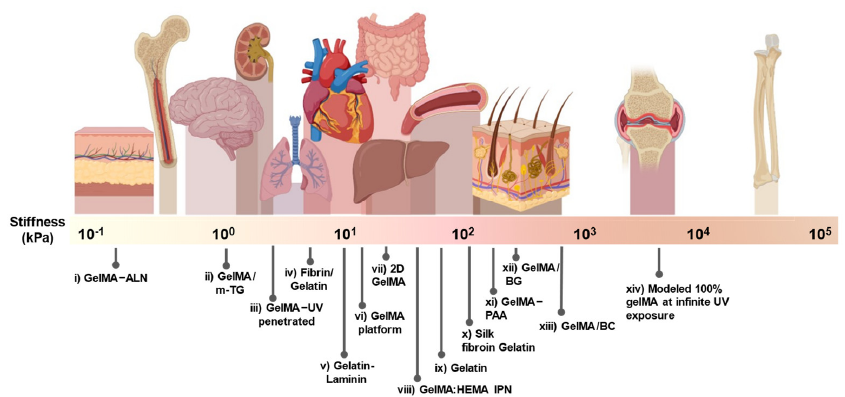
Figure 9. Depiction of gelatin tunability by comparing its stiffnesses against different tissue stiffness. ( i ) Alendronate-functionalized GelMA [154], ( ii ) GelMA/m-TG [121], ( iii ) GelMA–UV penetrated [155], ( iv ) Fibrin/gelatin [156], ( v ) Enzyme crosslinked gelatin-laminin hybrid [33], ( vi ) GelMA based platforms [33], ( vii ) 2D Photo-crosslinked GelMA [157], ( viii ) GelMA and poly(2-hydrox-ethyl methacrylate) (pHEMA) interpenetrating network (IPN) hydrogels [158], ( ix ) Gelatin of different concentrations [159], ( x ) Silk fibroin-Gelatin Bio-ink [160], ( xi ) GELMA-polyacrylamide (PAA) [161], ( xii ) GelMA/doped bioactive glass (BG) [162], ( xiii ) GelMA/bacterial cellulose (BC) [163], and ( xiv ) Theoretical value modeled for 100% GelMA gel at infinite exposure time [164]. Created with BioRender.com (accessed on 30 October